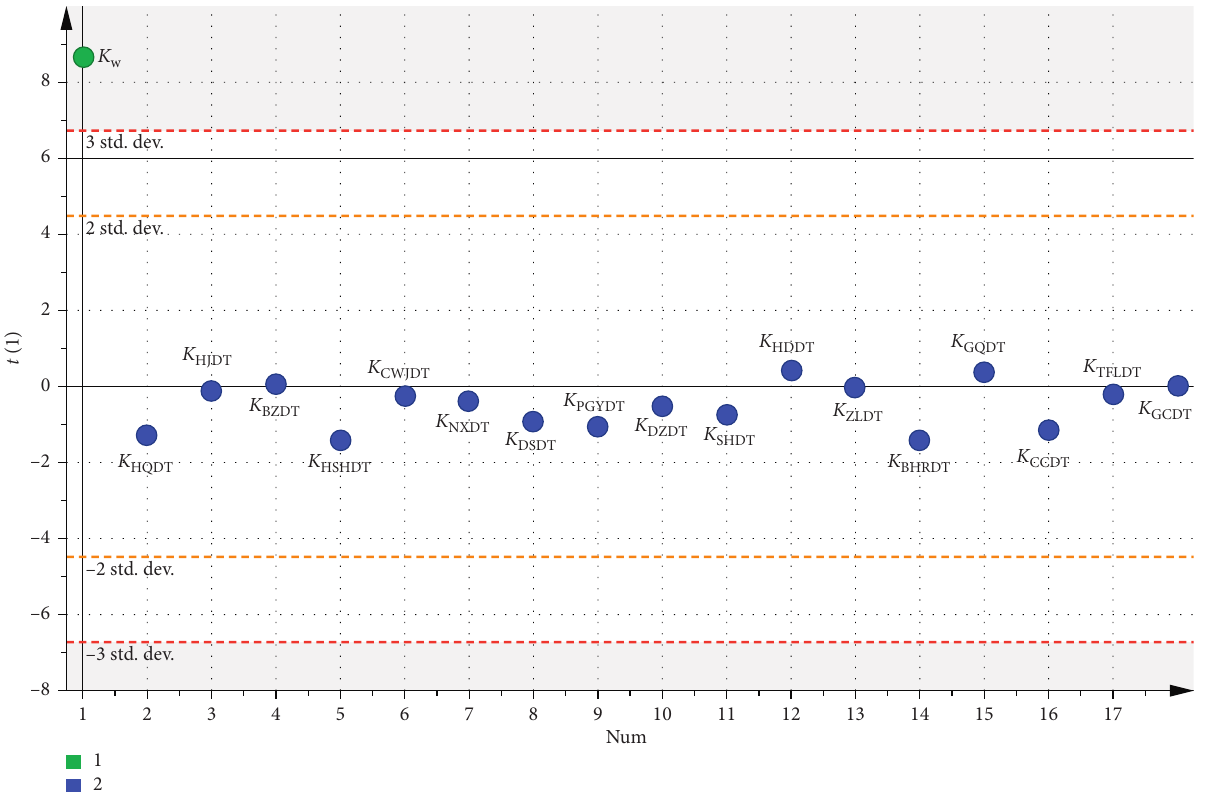
Figure 5: PCA score plot of degradation constants of flavonoids in water and each of the 17